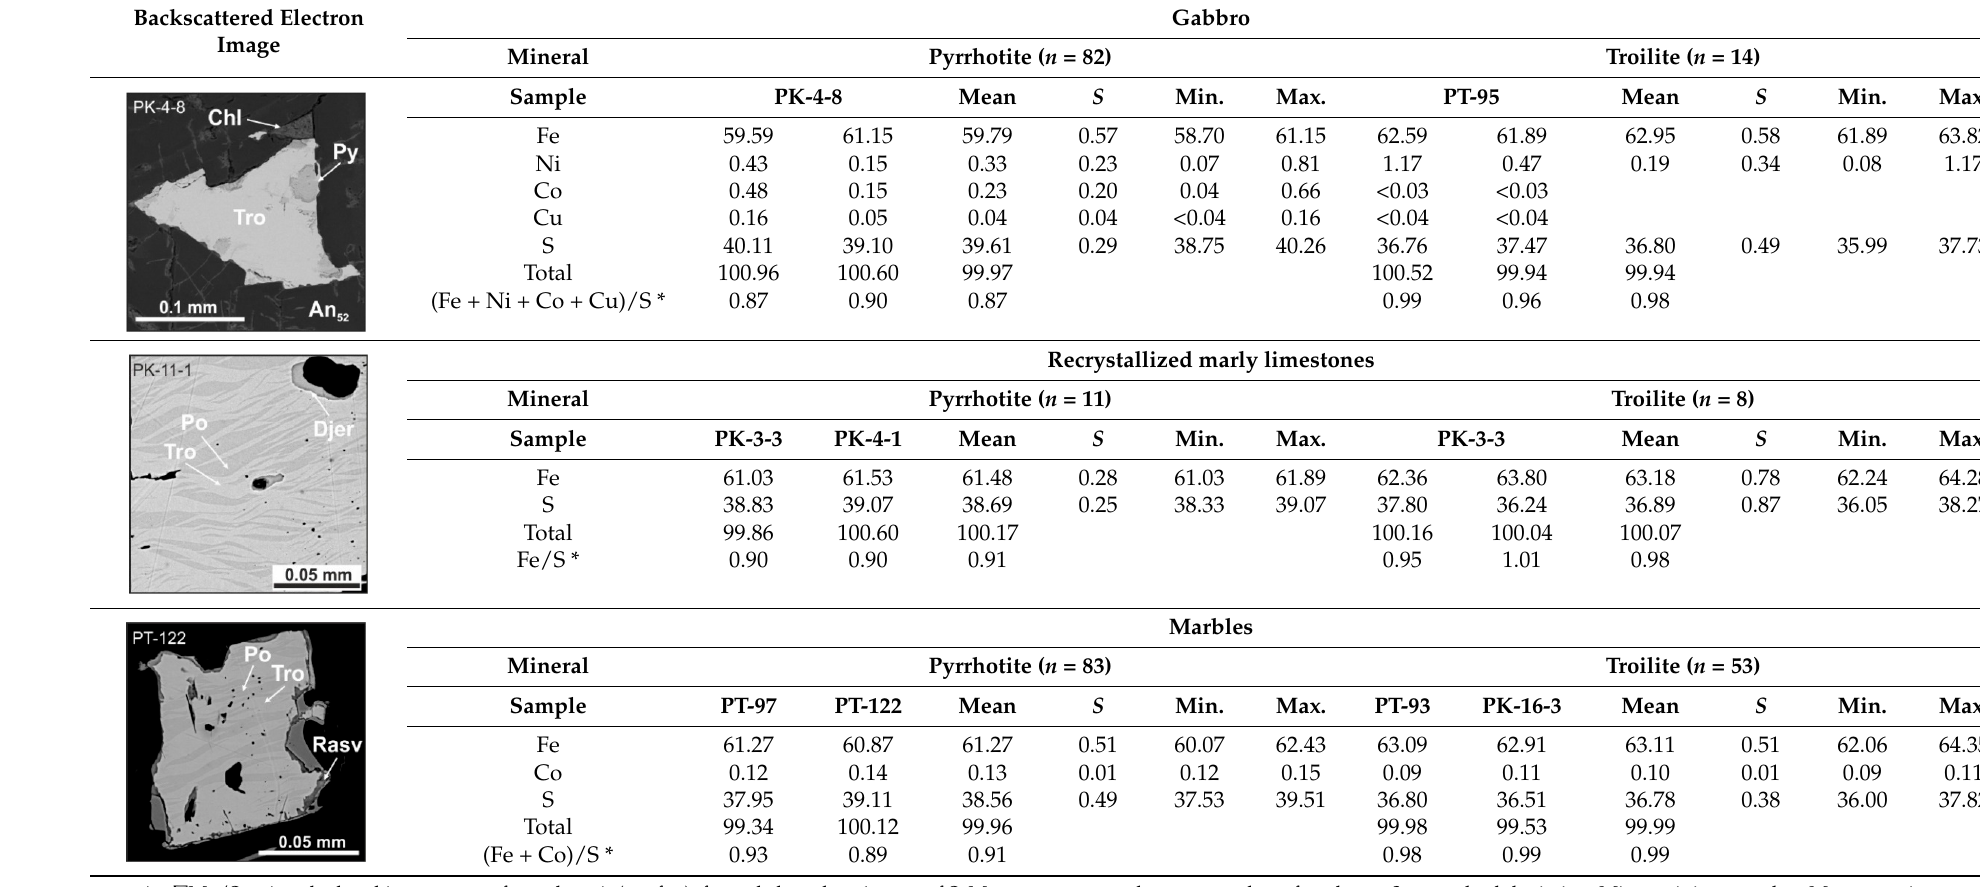
Table 4. Representative analyses and average compositions of pyrrhotite (Fe 1- х S) and troilite (FeS) from gabbro, recrystallized marly limestones, and marbles from the Kochumdek contact aureole (EPMA data, wt%). Backscattered electron